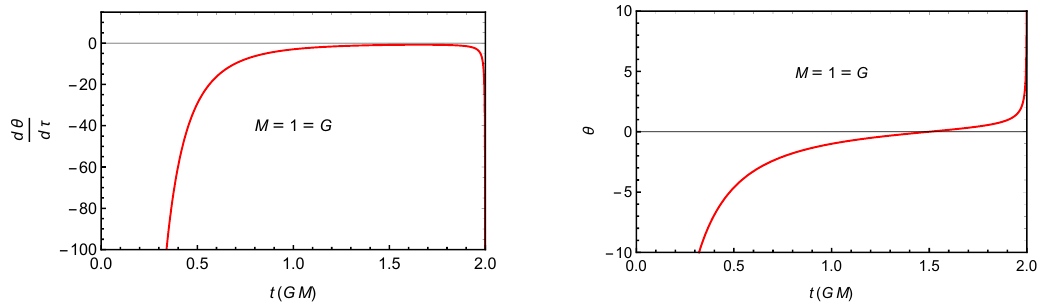
as a function of the Schwarzschild time t . Right: negative branch of θ as a Figure 2 . Left: dθ dτ function of t . Both θ and dθ diverge as we approach t → 0 . Note that the divergence at the horizon dτ is due to the choice of Schwarzschild coordinate